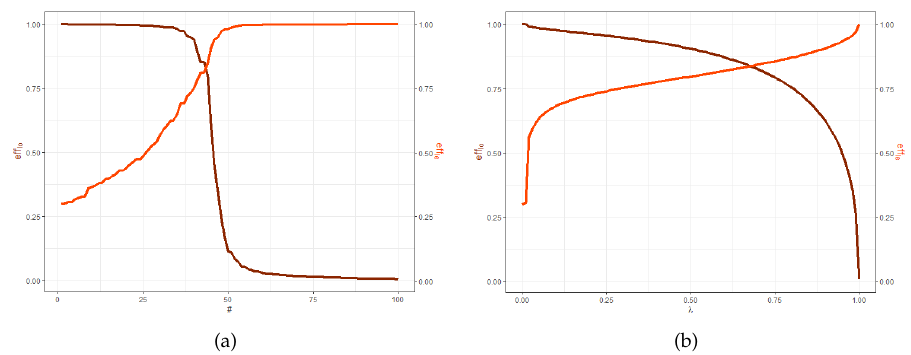
Figure 2. I -efficiencies for the homoscedastic model (in dark red) and heteroscedastic model (in light red). ( a ) Multi-objective algorithm. ( b ) Compound criterion.